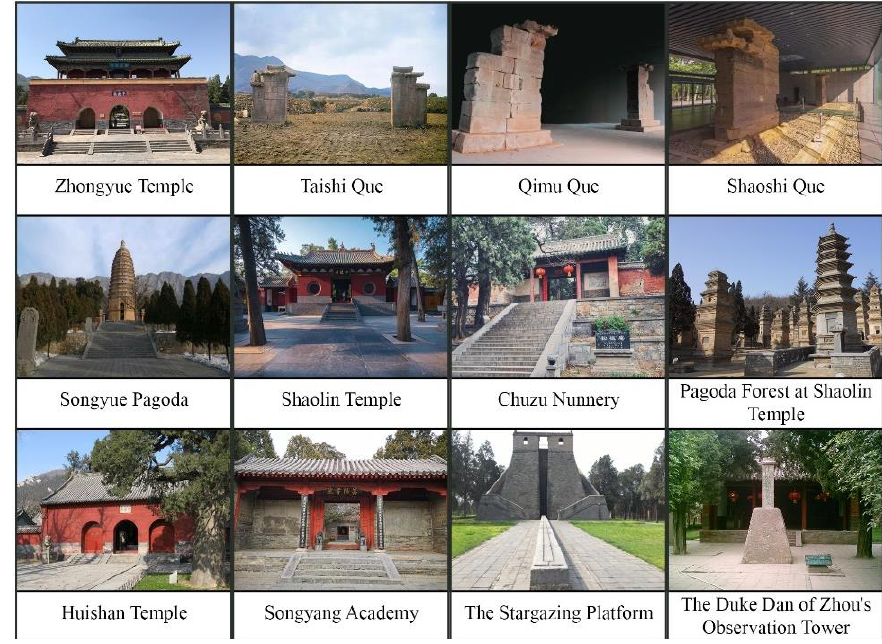
Figure 1. Historic monuments of Dengfeng in “the Center of Heaven and Earth” .